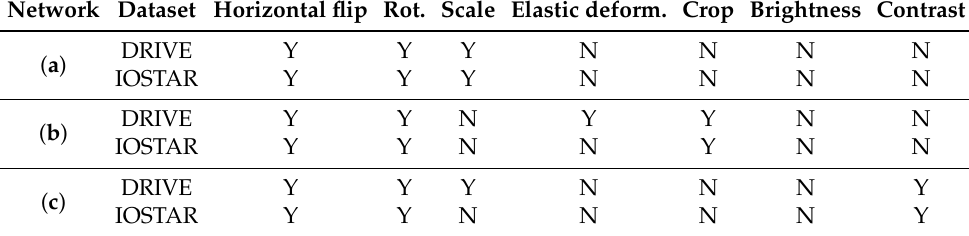
Table 1. Data augmentation used for training the networks, each of which is for ( a ) optic disc segmentation, ( b ) binary vessel segmentation and AV classification, and ( c ) vascular connectivity classification. Horizontal flipping, rotation (rot.), scaling, elastic deformation, cropping, random brightness, and contrast adjustment are selectively applied according to the task and the